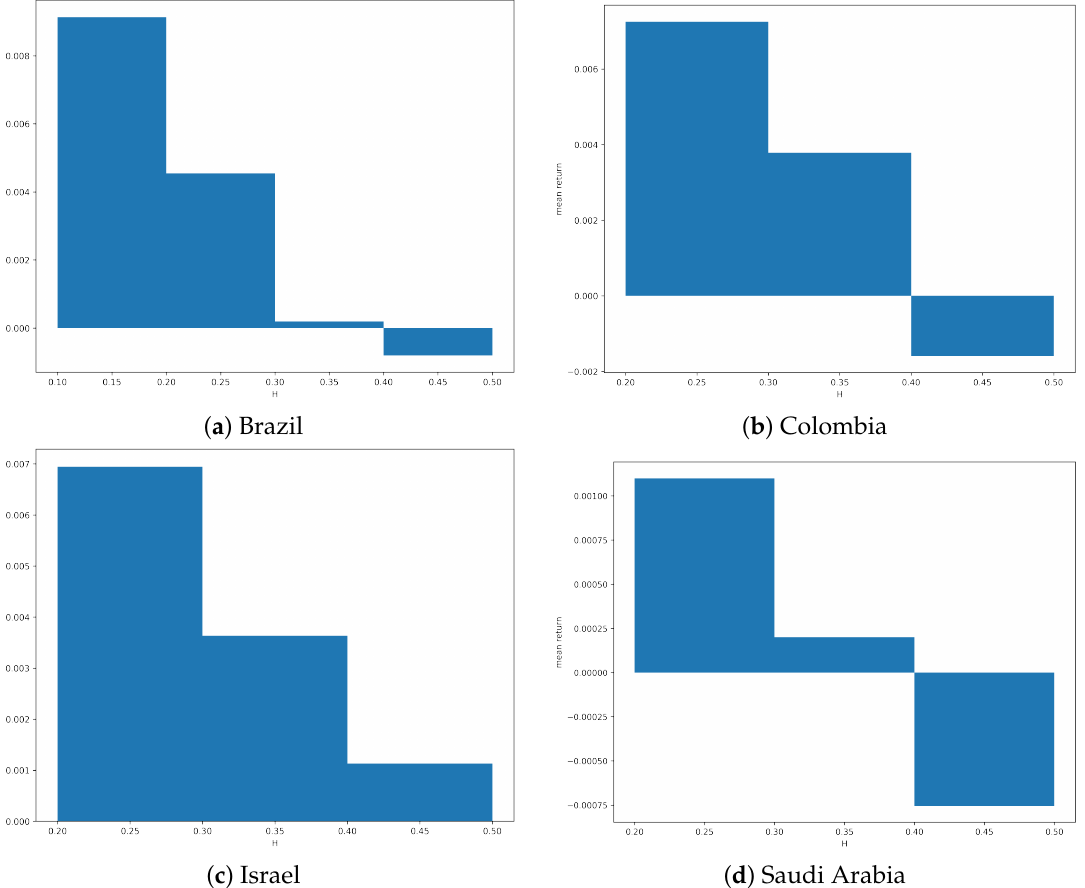
Figure 4. Comparison between the value of H and the mean return between countries for the period